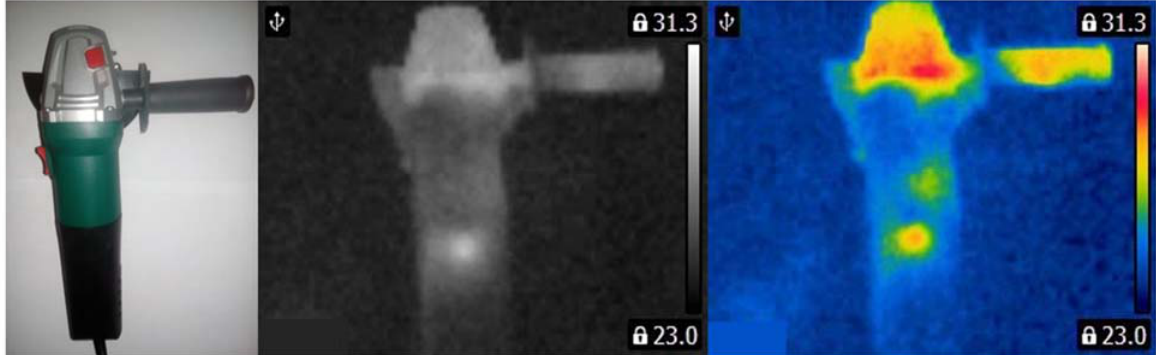
Figure 3. Healthy angle grinder.